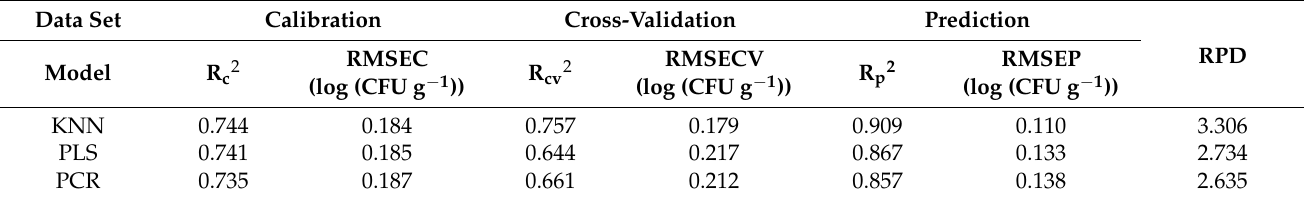
Figure 10. The predicted ipomeamarone content and total colony count based on E-nose data. ( A1 , A2 ) KNN model of ( A1 ) ipomeamarone and ( A2 ) total colony count. ( B1 , B2 ) PLS model of ( B1 ) ipomeamarone and ( B2 ) total colony count. ( C1 , C2 ) PCR model of ( C1 ) ipomeamarone and ( C2 ) total colony count. Table 4. Predicted results of ipomeamarone for C. fimbriata -infected sweetpotatoes by KNN, PLS, Table 5. Predicted results for total colony counts for C. fimbriata -infected sweetpotatoes by KNN, PLS, and PCR.